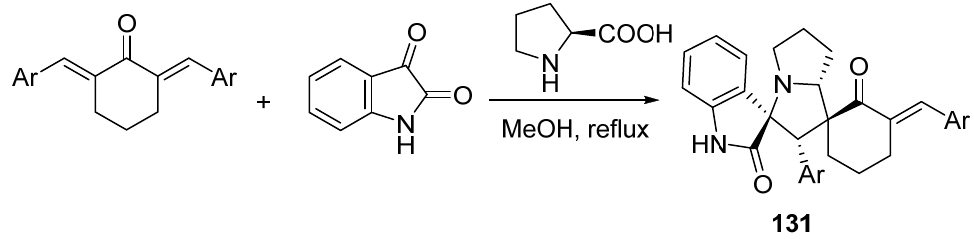
Figure 10. Spiro[indoline-3,2 ′ -quinolins] 121 of promising anti-leishmanial properties. Spirooxindoles 131 were prepared through cycloaddition of 2,6-bis(ylidend)cyclohexan ones and azomethine ylide (formed from the condensation of proline and isatin) (Scheme 45). Few of the synthesized agents revealed anti-leishmanial properties (a compound with Ar = 3-NO 2 C 6 H 4 is the most effective agent with IC 50 = 6.8 µ g/mL relative to amphotericin B (IC 50 = 0.29 µ g/mL)